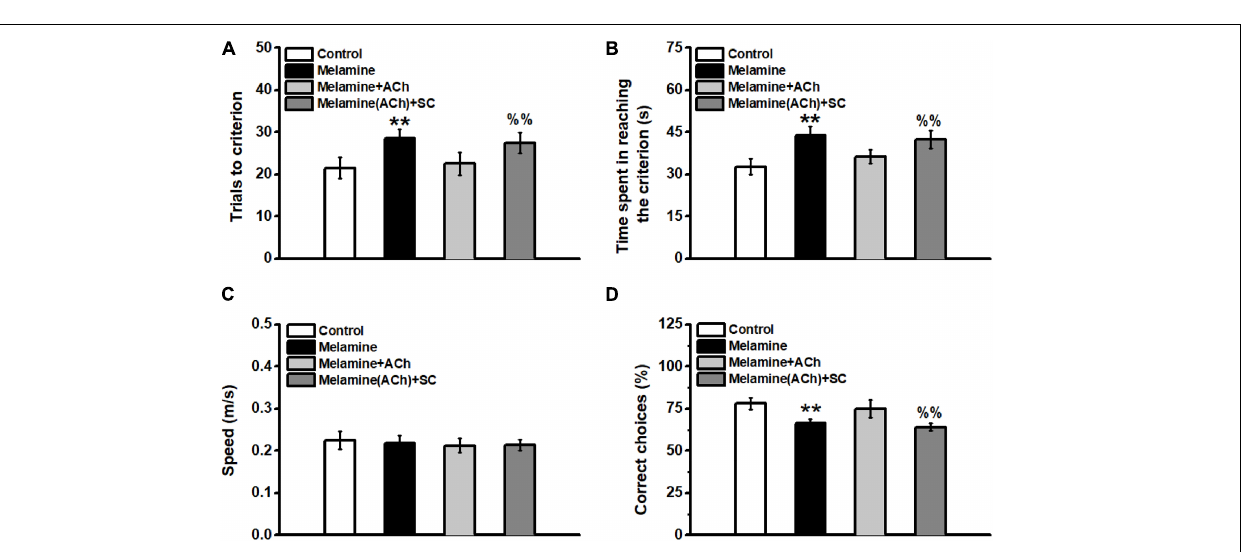
FIGURE 5 | Spatial learning in the Y-maze task. (A) Total trials to the criterion. The total trails to the criterion of the melamine group were significantly increased compared to the control. Injection of acetylcholine (ACh) mitigated the spatial learning deficits by reducing the total trial numbers during spatial training. (B) Total time spent in reaching the criterion. No statistical difference was found among all groups. (C) Velocity of animals during the whole behavioral test. No difference was found among groups. (D) Percentage of correct trials during the memory test. ** P < 0.01, melamine vs. control and melamine+ACh; %% P < 0.01, melamine(ACh)+SC vs. control and